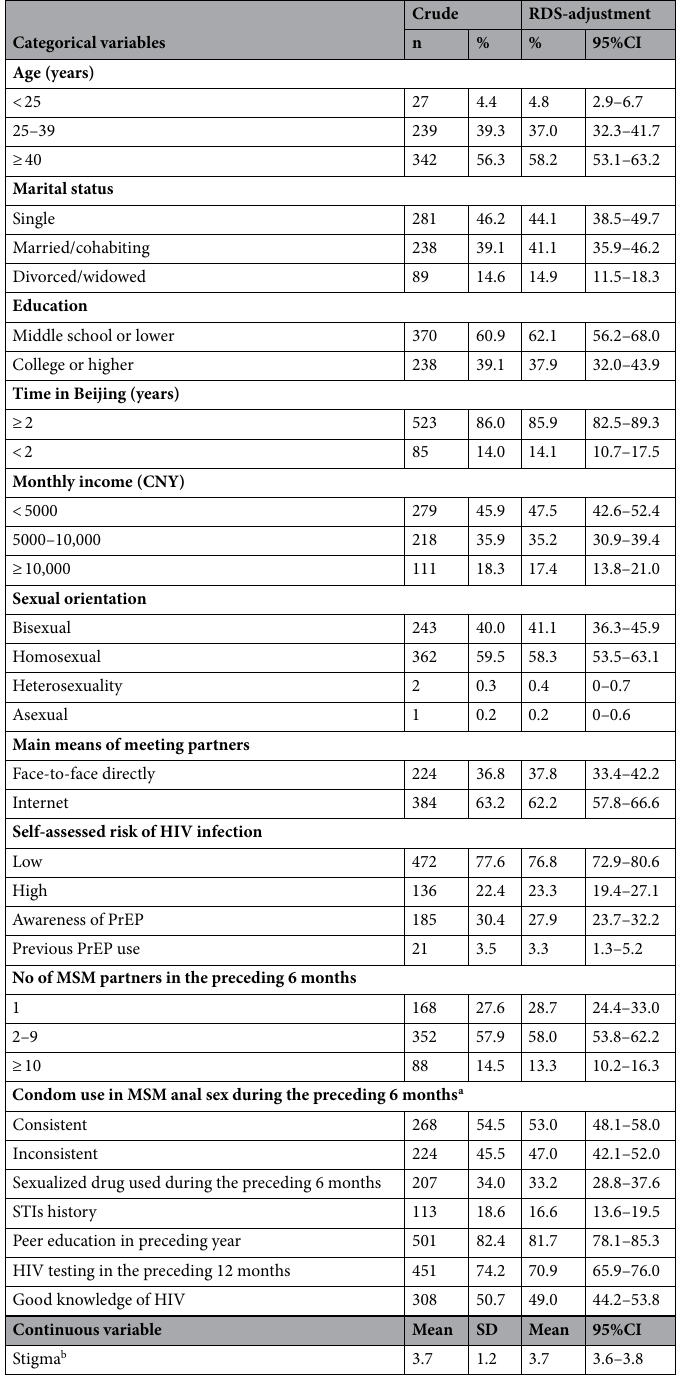
Table 1. Demographic and behavioral characteristics of MSM recruited in 2021 in Beijing, China (N = 608). a 492 MSM had MSM anal sex during the preceding 6 months. b measured on a 7-point scale from 0 to 6, 6 = extremely